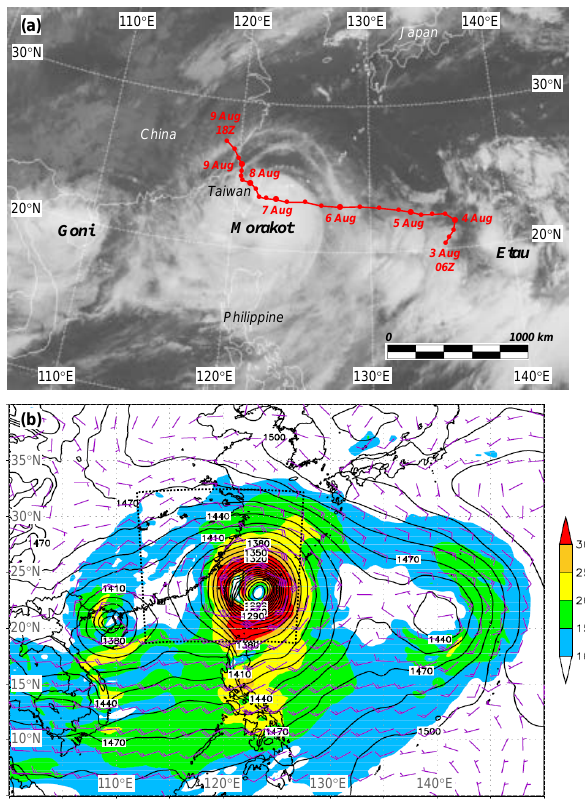
Figure 1. (a) The JTWC best-track of Typhoon Morakot (TY0908) overlaid with MTSAT IR cloud imagery at 00:30UTC, 7 Au- gust 2009. The TC positions are given every 6h. (b) The ECMWF- YOTC analysis of geopotential height (gpm, contours) and hori- zontal winds (ms − 1 , full (half) barb = 10 (5)ms − 1 , wind speed shaded) at 850hPa at 00:00UTC, 7 August 2009. The domain of 3km experiment is also plotted (dotted